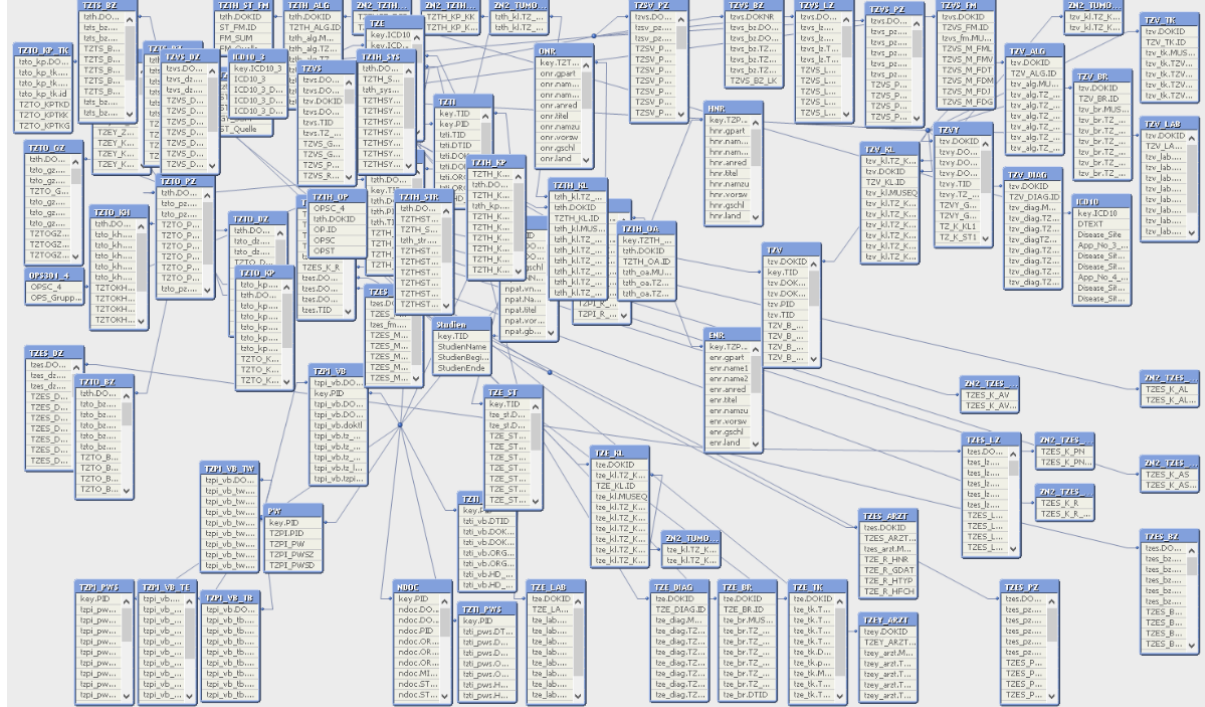
Figure 1. Screenshot of the current data model illustrating its complexity. The tables are framed in blue, displaying all of their included fields. The tables are linked via specifically chosen key attributes (eg, patient, tumor, or document